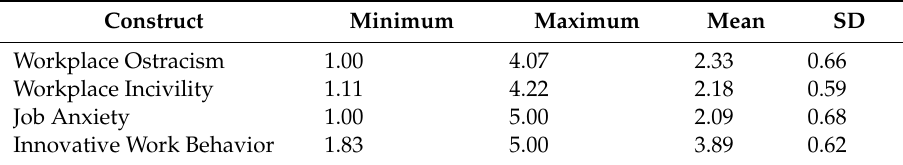
Table 3. Descriptive